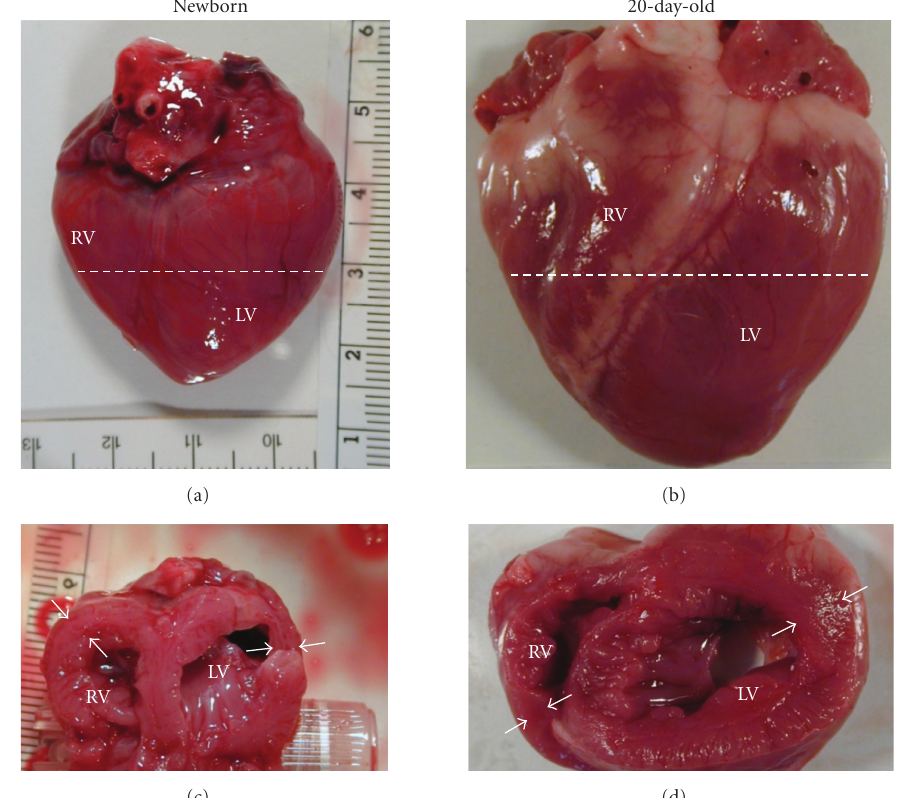
Figure 1: Heart dimensions (a and b) and left/right ventricular cross-sections (c and d) of newborn and 20-day-old piglets. LV/RV— left/right ventricle. (a), (b) Levels of cross sections are shown by dotted lines. (c), (d) Boundaries of the LV/RV free wall are marked by white